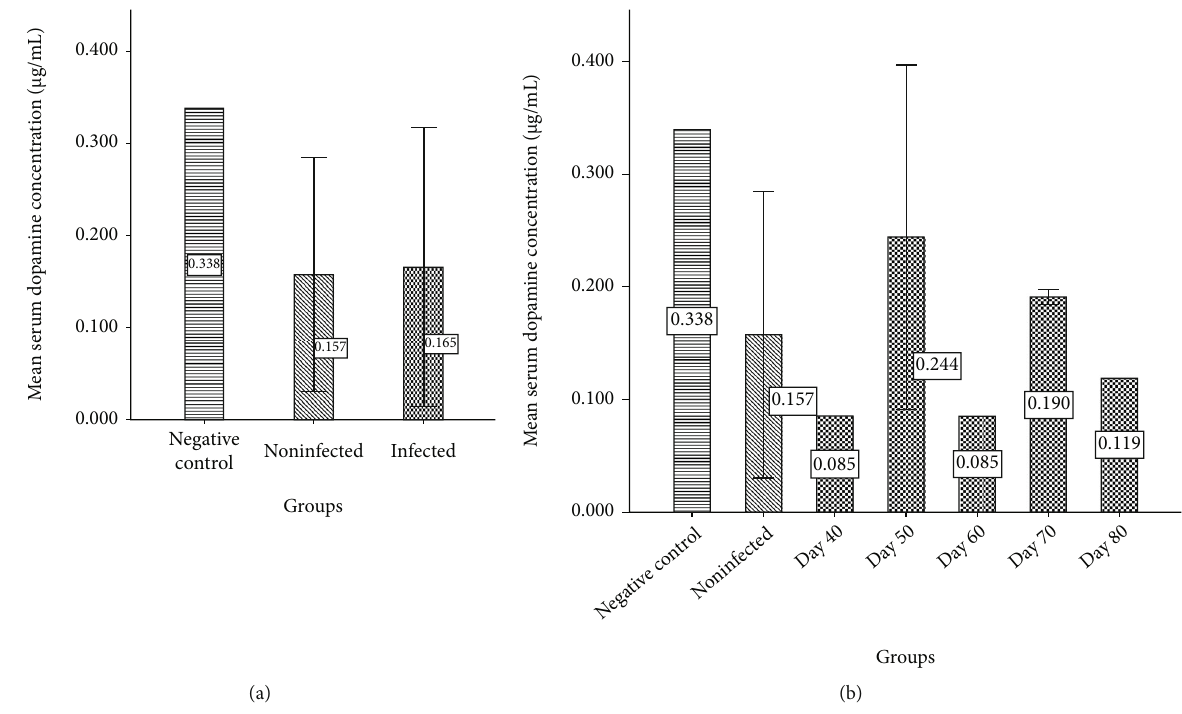
Figure 6: The average serum dopamine level ( μ g/ml) in negative control, PD uninfected mice, and PD mice infected with Toxoplasma . (b) The average of the serum dopamine of the PD mice infected with Toxoplasma at days 40, 50, 60, 70, and 80 in comparison with negative control and PD uninfected